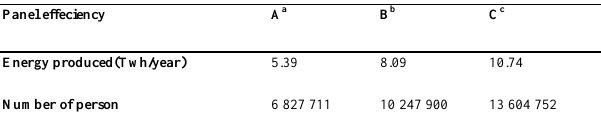
Table9. Number of inhabitants could benefit from PV production using different module efficiencies in high suitable area. Panel effeciency